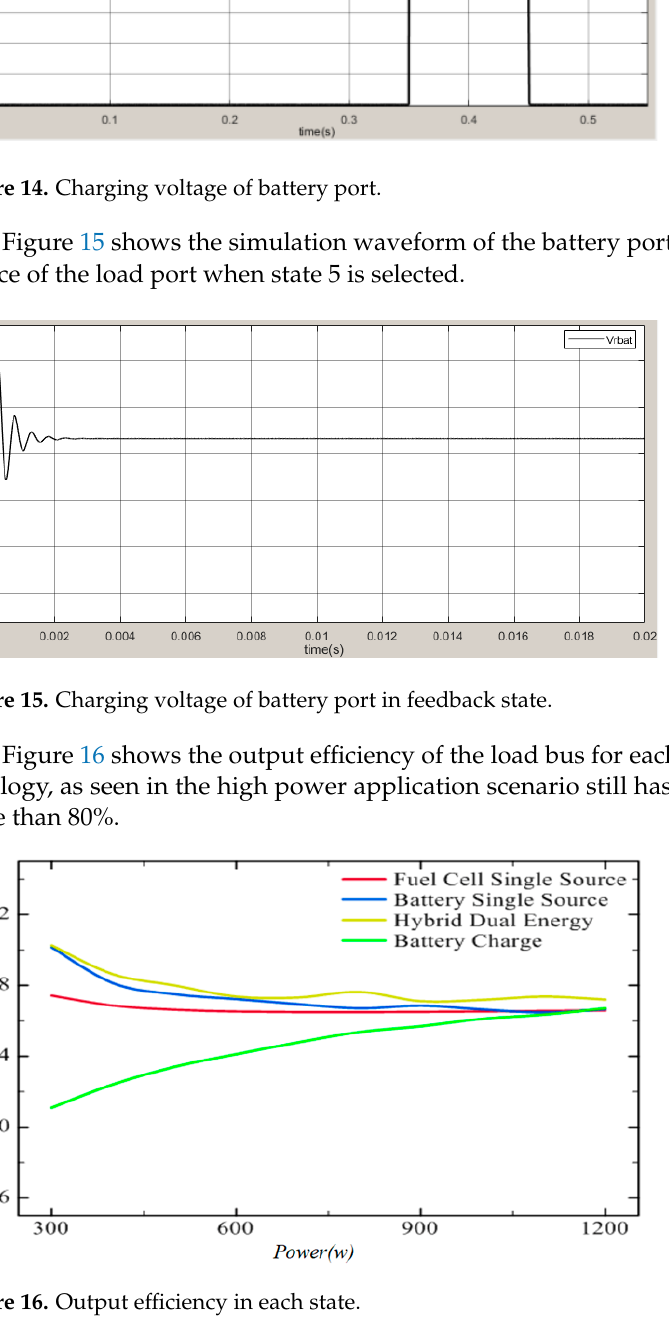
Figure 16. Output efficiency in each state.